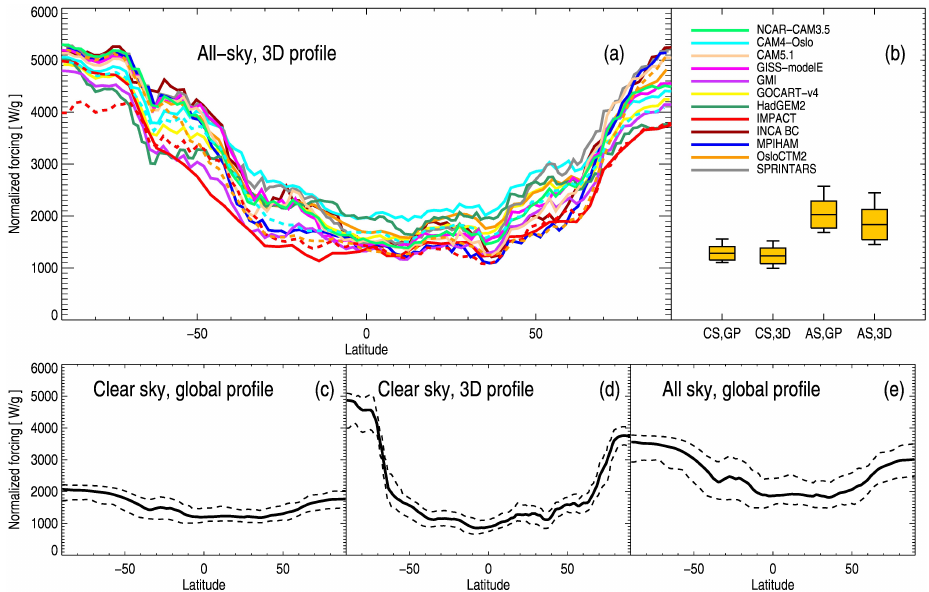
Fig. 5. Breakdown of spread in BC forcing efficiency. (a) Zonal mean of BC RF per unit mass using 3-D monthly resolved efficiency profiles and all sky conditions, for all models. Solid lines are results from AeroCom phase 2, dashed lines from phase 1. (c–e) Model mean (solid line) and maximum/minimum (dashed lines) when instead using (c) a global, annual mean efficiency profile and clear sky conditions, (d) 3-D profile and clear sky conditions, and (e) a global profile and all sky conditions. (b) shows the global mean values for the four cases. Boxes show one standard deviation on the model spread, whiskers show maximum/minimum